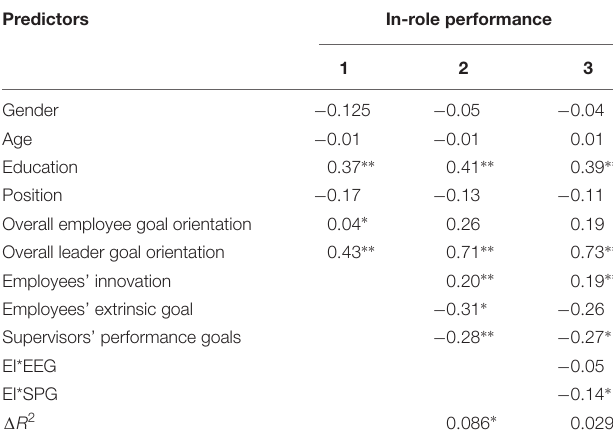
TABLE 5 | Results of multilevel analyses testing hypotheses.